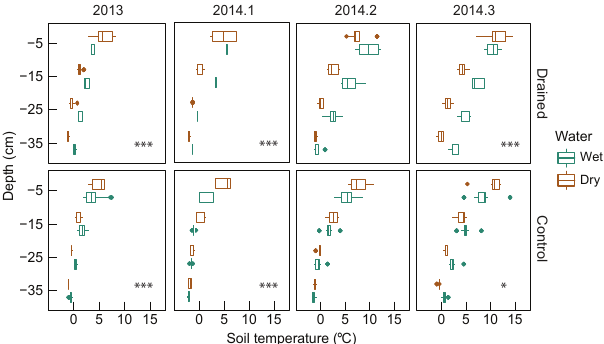
Figure 4. T soil profiles based on observations at 5, 15, 25, and 35cm depths from even-numbered plots each in the drained (top) and the control (bottom) transects. Boxplot contains median, 25 and 75% quartiles, and ± 1.5 interquartile ranges. To minimize the impact of the diurnal temperature cycle on this temporally discontinuous data set, the time window for averaging was restricted to 13:00– 17:00LT. Panels from left to right show data from 2013, as well as from three subseasons of the growing season of 2014: (2014.1) 15 June–5 July, (2014.2) 6–26 July, and (2014.3) 27 July–20 Au- gust. Data subsets where significant differences in WTD between the wet and the dry plots were detected are marked with asterisks ( ∗∗∗ P< 0 . 001, ∗∗ P< 0 . 01, ∗ P< 0 . 05).